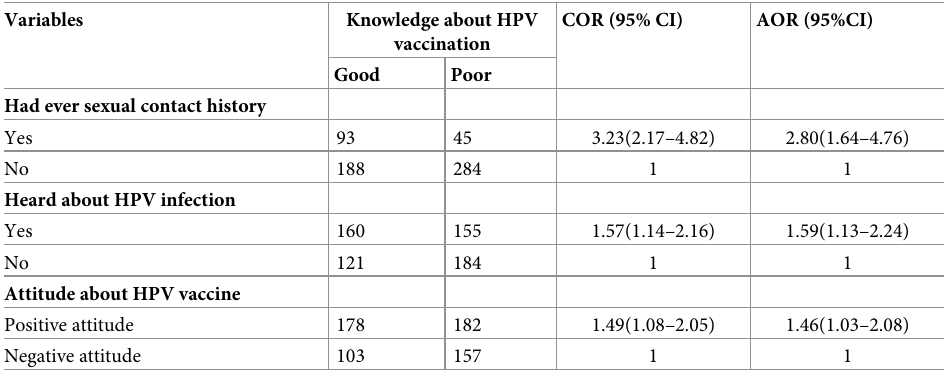
Table 4. Factors associated with knowledge about HPV vaccine among female preparatory school students, Bahir Dar, Ethiopia, 2021.